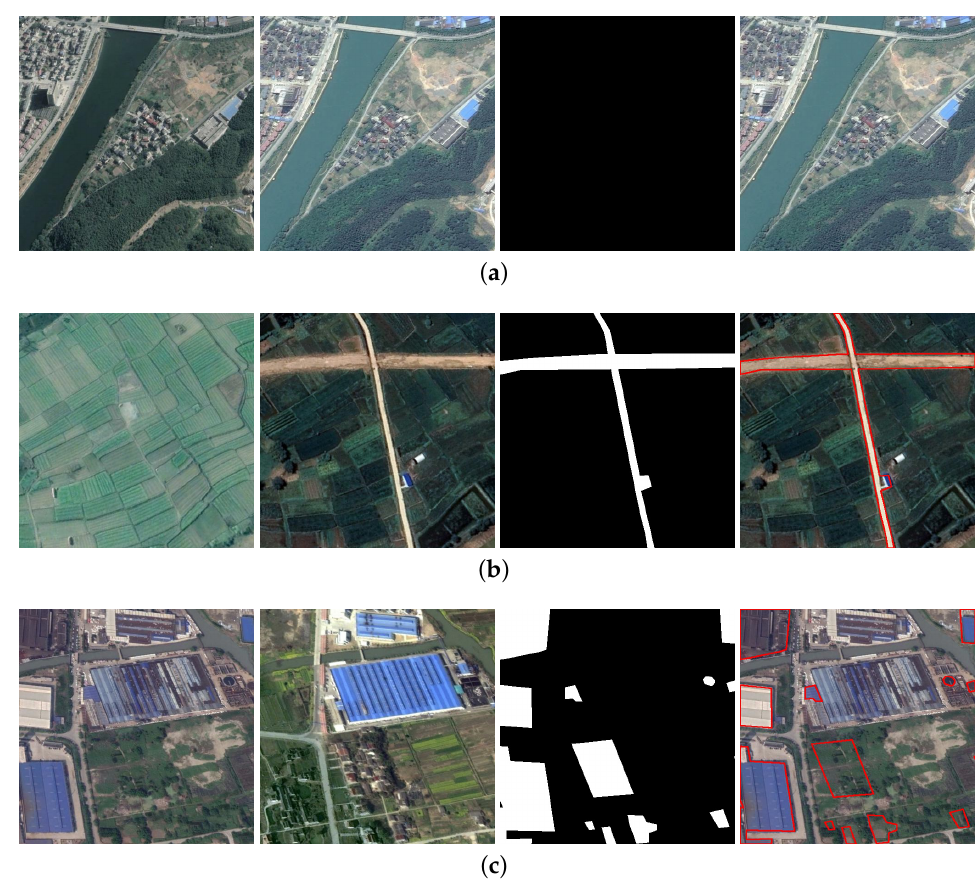
Figure 8. Display of some bitemporal Google Earth images in the dataset. In each line, from left to right, the first two Google Earth images are at the same place of different times. The third image is the ground truth, in which the black areas represent the unchanged, and the white represent the changed. The red lines in the fourth image are the parts of the changed areas. Panels ( a – c ) represent areas of changed in different proportions, respectively: ( a ) unchanged areas, ( b ) 9% of changed areas, and ( c ) 20% of changed areas.